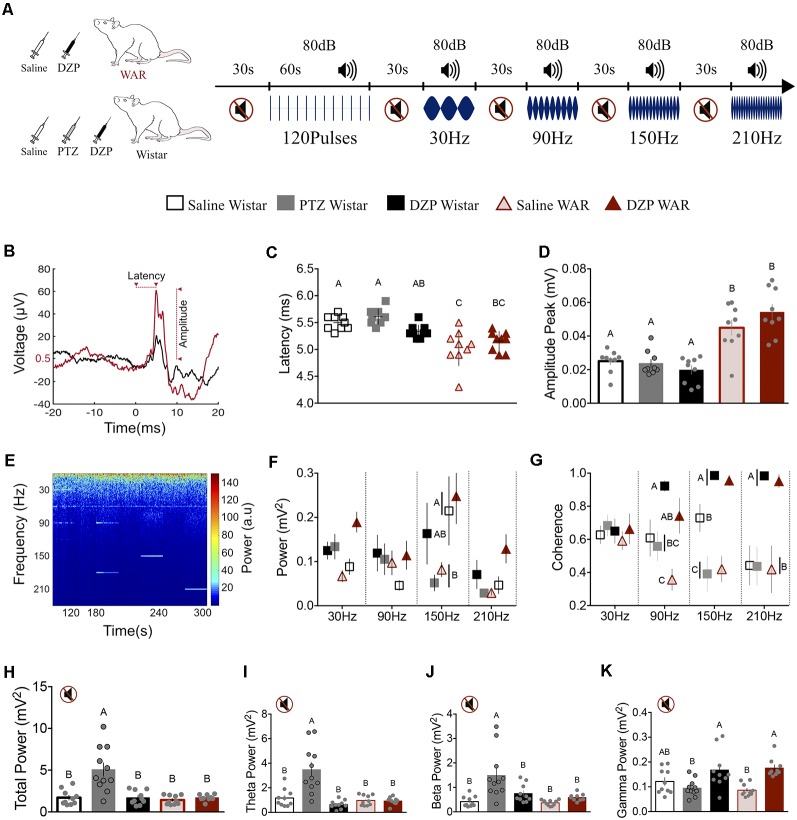
Neuronal excitability level and rat strain modify the inferior colliculus (IC) basal activity (H–L) and the sound-evoked responses by transient (B–D) and ASSR (E–G). (A) Illustrative protocol sequence. (B) Representative transient evoked response (120 averaged pulses) from Saline Wistar (black) and Saline WAR (red) group. The arrows indicate the start-end point for WAR Saline latency and amplitude. The Y-axes 0.5 μV refers to the WAR Saline baseline value determined by averaging the 20 ms-time-window prior to sound presentation. Peak amplitude measurement was determined against this baseline. (C,D) Transient response peak latency and amplitude. (E) IC ASSR demonstrative spectrogram. (F,G) IC power and coherence according to the sound stimulation modulation frequencies (30–210 Hz). (H–K) IC basal activity during the silent period; Total Power and Theta, Beta and Gamma frequency bands. Different letters represent statistical significance p < 0.05.